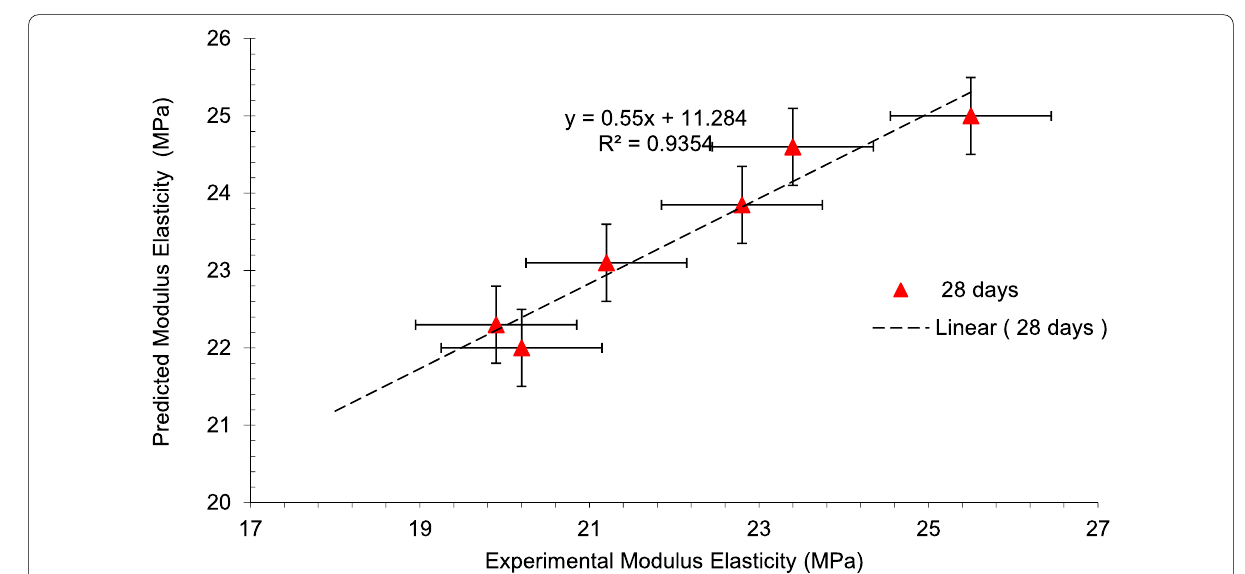
Fig. 20 Laboratory and predicted value of